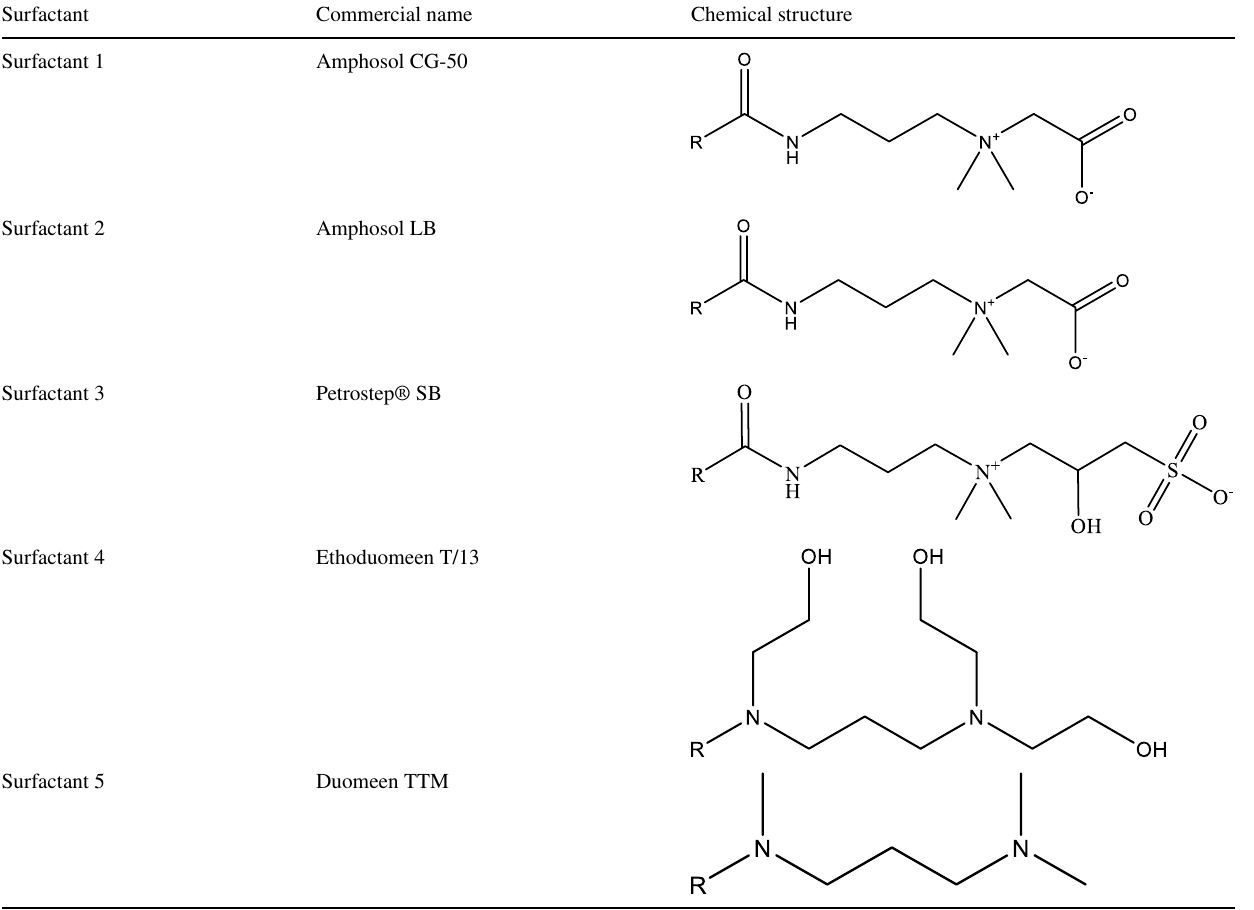
Amphosol LB and Amphosol CG-50 have similar structures except that Amphosol LB made using narrow cut methyl esters and Amphosol CG-50 from refined coconut